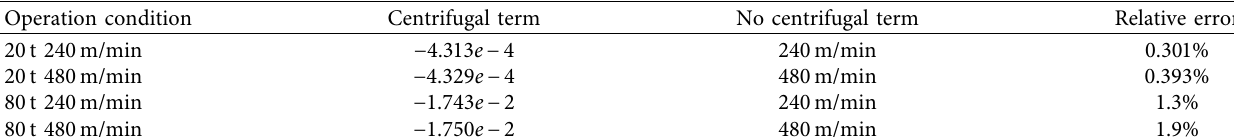
Table 3: Numerical results of vertical displacement of girder span.